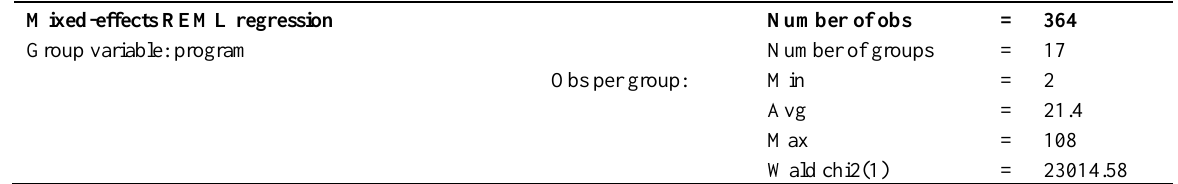
Table 9: Mixed Effect Model of Client Selection Criteria on Incubator